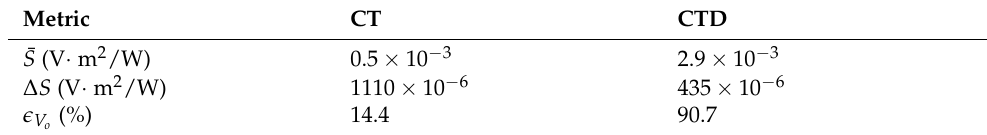
Table 4. CT and CTD metrics.